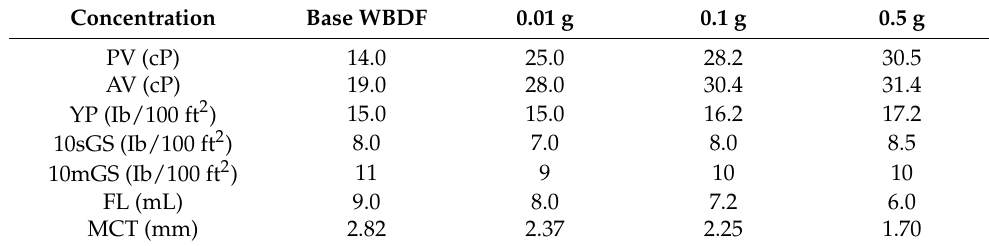
Table 3. Rheological properties of raw welding waste.